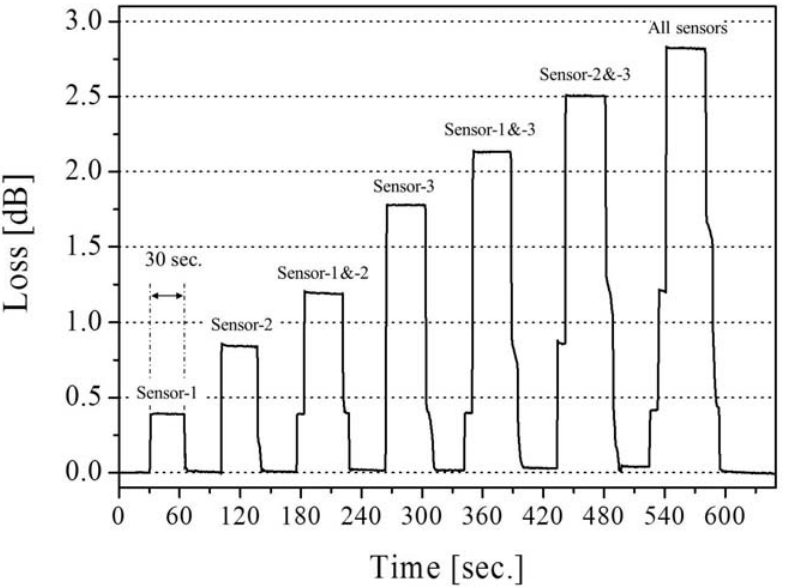
Figure 6. Real-time response in optical loss for each detection pattern.